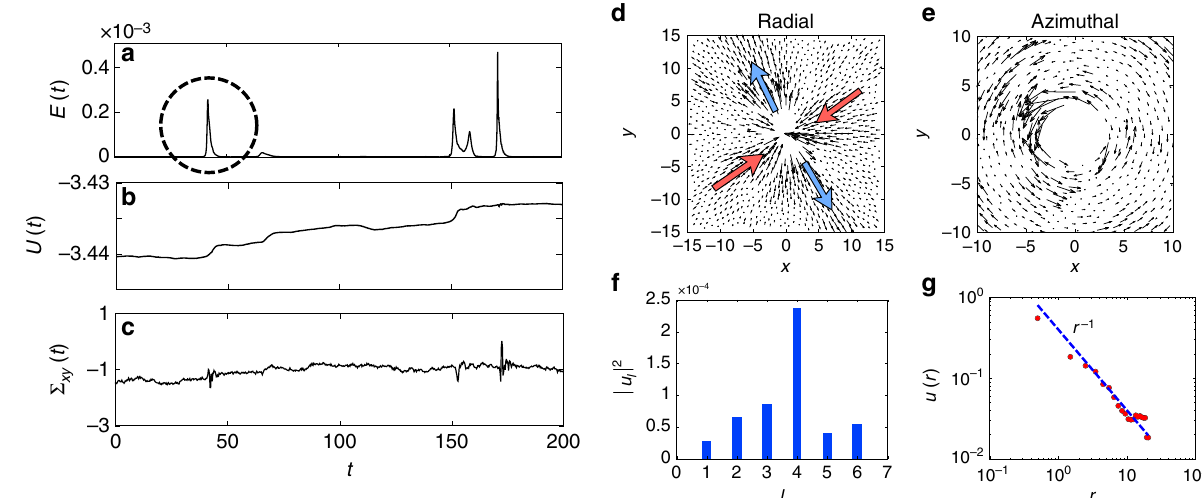
Fig. 3 Intermittent bursts associated with plastic yielding. τ p = 10 4 , f = 1.0 (marked by green triangle in Fig. 1). We monitor the time series of a mean kinetic energy E ( t ), b potential energy U ( t ) and c local shear stress Σ xy ( t ), at a value of f < f * ( τ p ) where the burst events are isolated and rare. Note that in the kinetic energy time series, we have subtracted out the centre-of-mass contribution. d – g The displacement fi eld pro fi les surrounding a single kinetic energy burst event (encircled in a ): d show the radial component of the displacement fi eld with a clear shear axis and quadrupolar symmetry (schematically highlighted using thick arrows), and e shows the azimuthal component with signs of vorticity; the arrows in the plots have been scaled up for visibility. f The fourfold symmetry shows up as a dominant l = 4 mode in the power spectrum of the radial component of the displacement fi eld P u ð r ; θ Þ ¼ u ð r Þ exp ð(cid:3) il θ Þ , where we average over r for better signal to noise. g Spatial pro fi le of the radial component of the displacement shows a 1/ r fall l l from the event. This implies that the deformation associated with a single, isolated yield event is an Eshelby